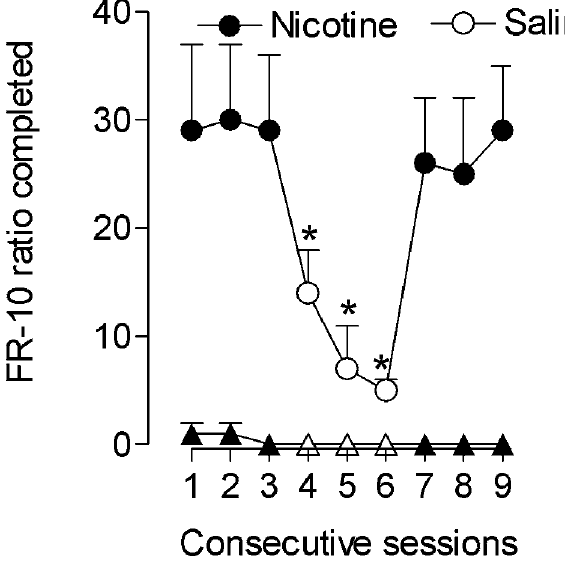
Figure 3. Maintenance, extinction and reacquisition of self-administra- tion behavior over consecutive sessions under the FR 10 schedule of reinforcement. Numbers of injections per session during consecutive nicotine (10 m g/kg per injection, filled symbols) and saline self- administration sessions (open symbols) are presented. Symbols represent the mean ( 6 SEM) number of ratios completed on the active (circle) or inactive (triangle) levers per session from five squirrel monkeys. * P , 0.05, compared to nicotine sessions.